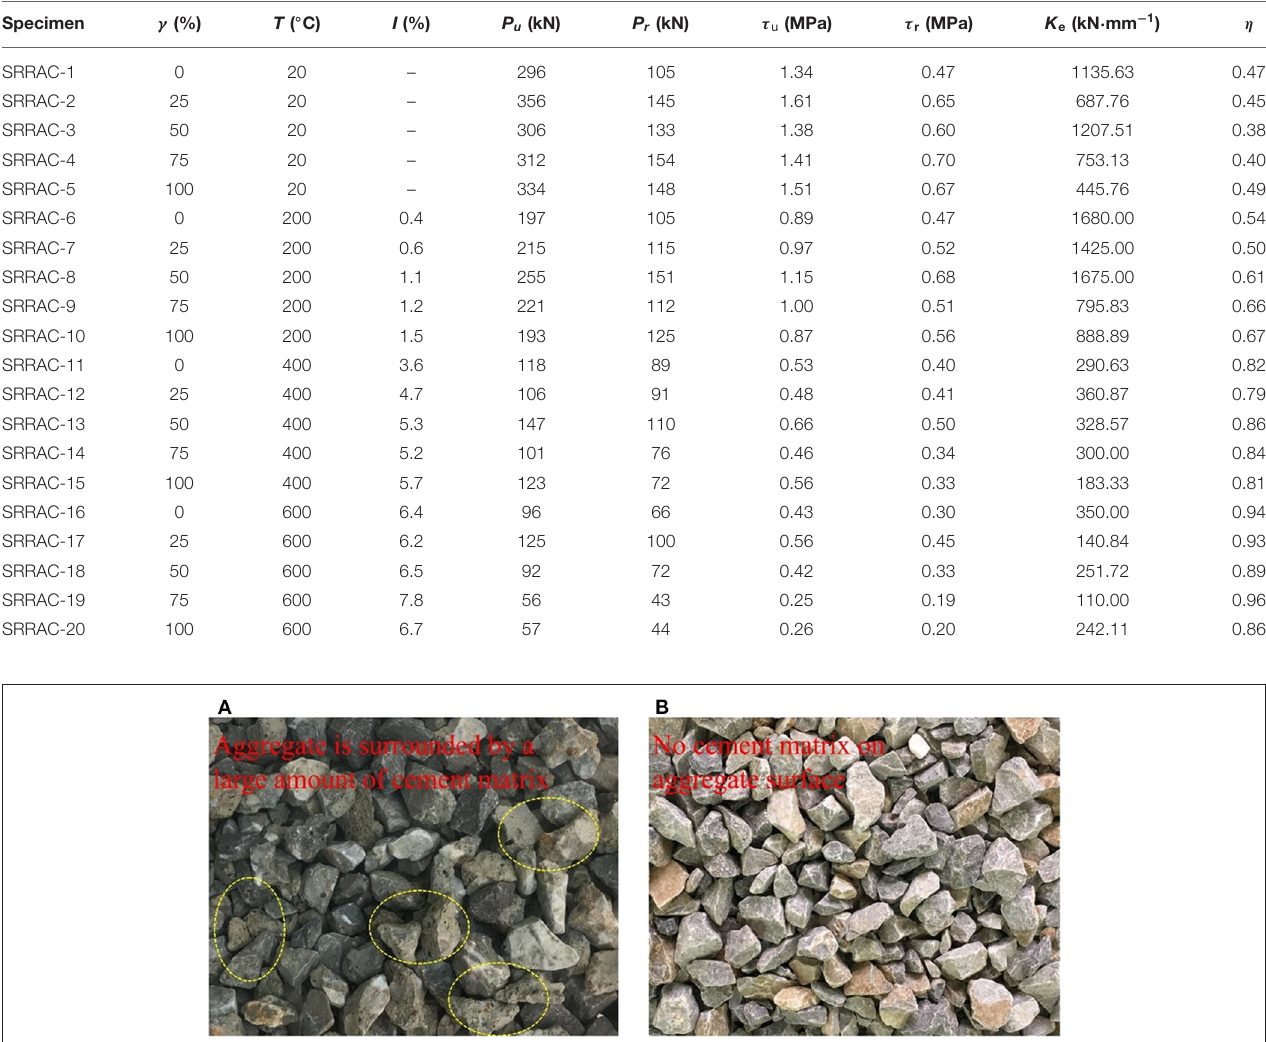
TABLE 1 | Design parameters of specimens and main test results.